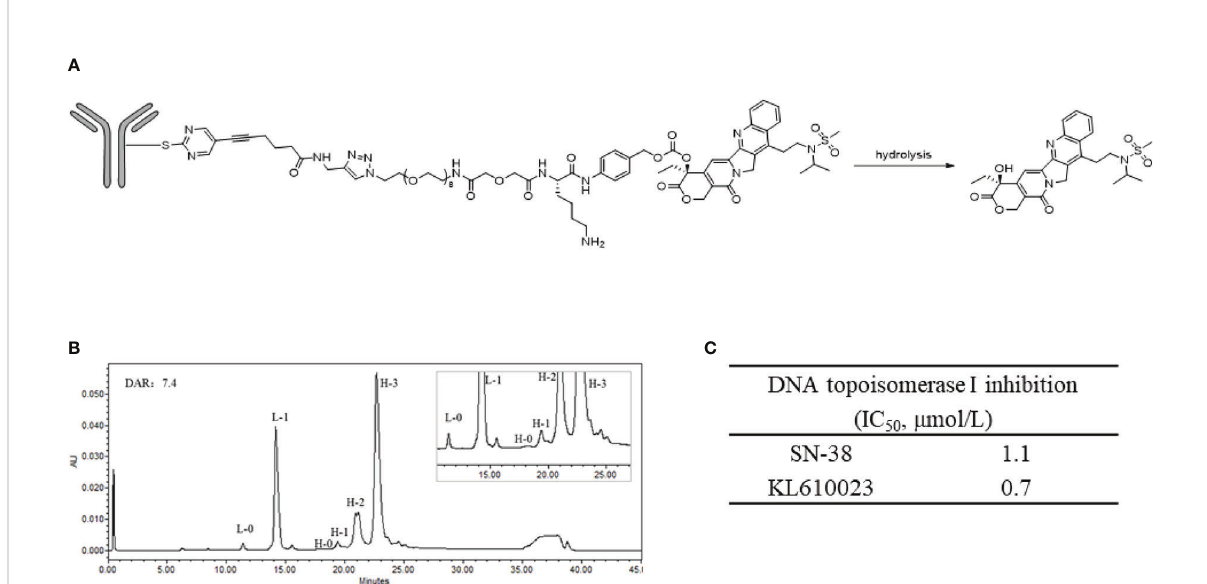
FIGURE 1 Structure and characterization of SKB264. (A) The chemical structure of the linkage of SKB264. (B) The distribution of the conjugated drug determined by the reverse-phase chromatography analysis (L-0: Unconjugated light chain, L-1: Light chain conjugated with one payload, H-0: Unconjugated heavy chain, H-1: Heavy chain conjugated with one payload, H-2: Heavy chain conjugated with two payloads, H-3: Heavy chain conjugated with three payloads). (C) Comparison of the inhibitory activity of cell-free DNA topoisomerase I between SN-38 and